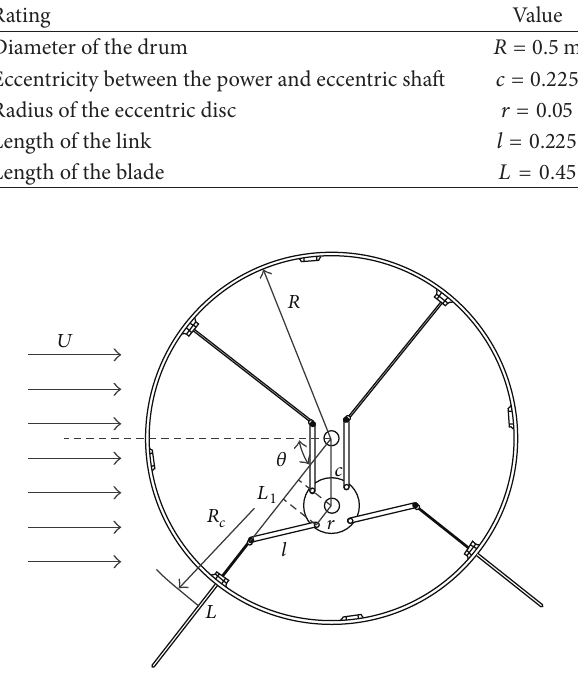
Figure 3: Schematic of the turbine